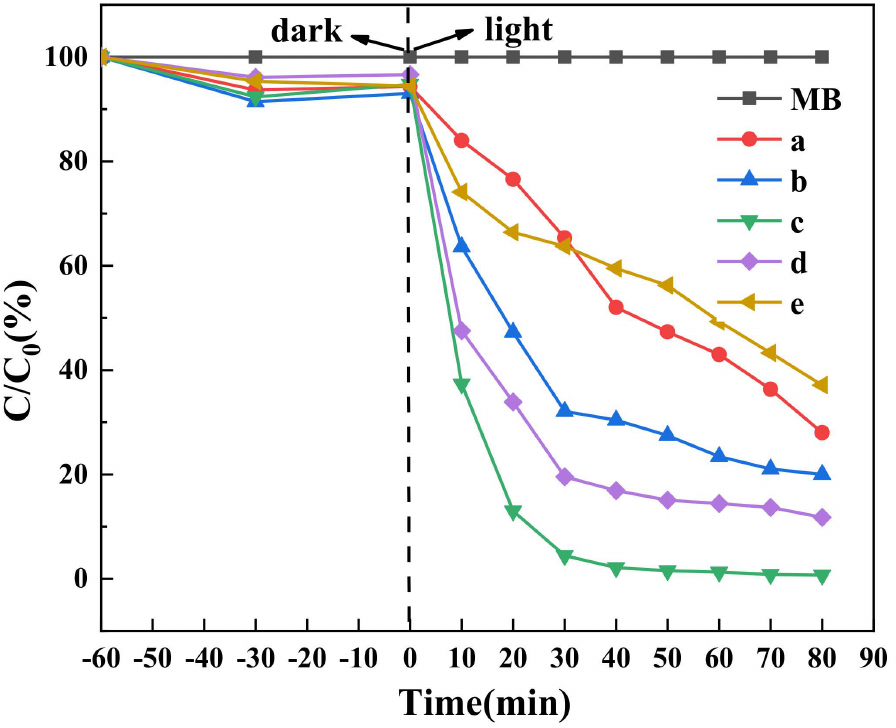
Figure 8. Photocatalytic effect of pure ZSM-5 ( a ) and composite products with different Zn/Si ratios Zn-ZSM-5 n(Zn)/n(Si) of: ( b ) 1:200; ( c ) 1:100; ( d ) 1:50; ( e ) 1:25. Experimental condition: V = 100 mL, T = 5 ◦ C; catalyst dose, 0.2 g/L; initial concentration of pollutant, 50 mg/L; initial concentration of oxidant = 0.8 mmol/L; pH =